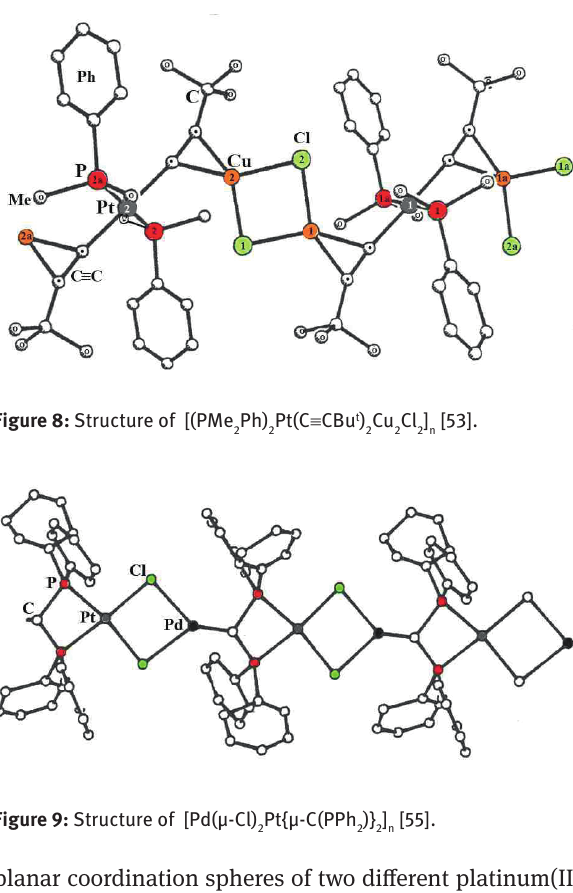
Figure 9: Structure of [Pd(µ-Cl)